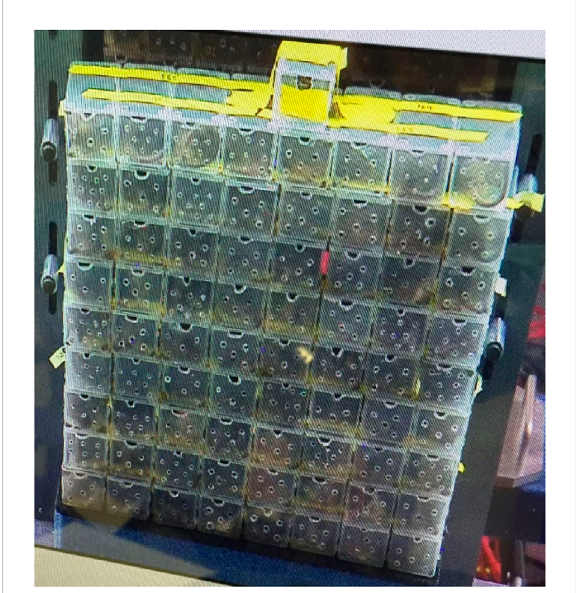
FIGURE 2 Setup for irradiating mice with 1 GeV/u 28 Si 14+ or 16 O 8+ ions. The 9 × 8 structure holds 72 mice in individual compartments. Ventilationholesandahigh-speedfankeptanimalsatcomfortable